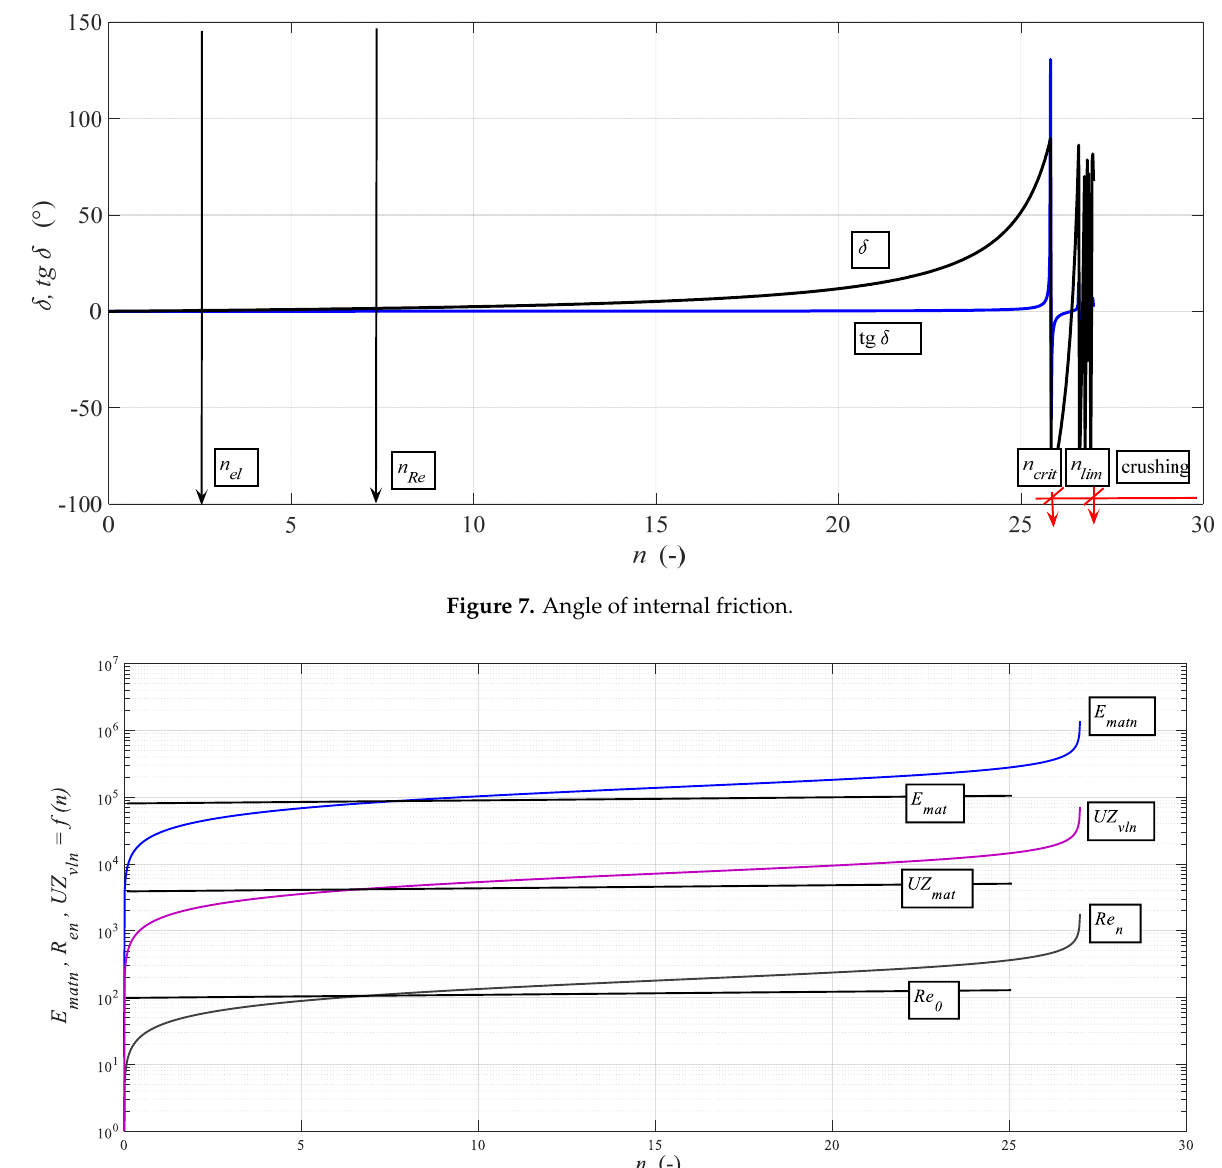
Figure 6. Dependence of ( Re nT , Re nM ) = f( n ).